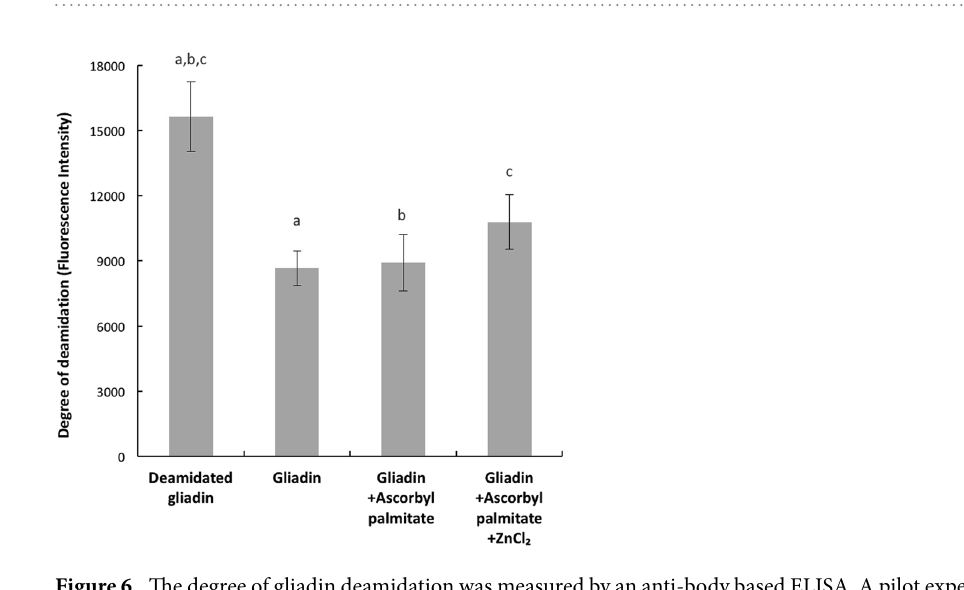
Figure 6. The degree of gliadin deamidation was measured by an anti-body based ELISA. A pilot experiment was conducted to confirm the inhibitory effect of ascorbyl palmitate on TG2 activity. There was no significant difference between TG2 processed ascorbyl palmitate treated gliadin and the unprocessed gliadin control (p = 0.75). No effect of ZnCl 2 could be observed since TG2 activity was already silenced. The letters a, b, c indicate significant differences between deamidated and non-deamidated